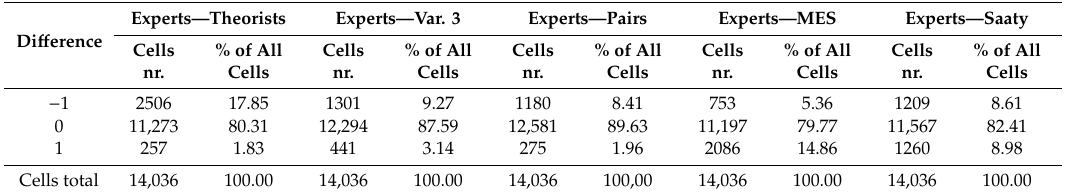
Table 6. Absolute numbers and percentage share of di ff erences from all pixels in the Jedovnice area for individual MCA variants related to the Experts